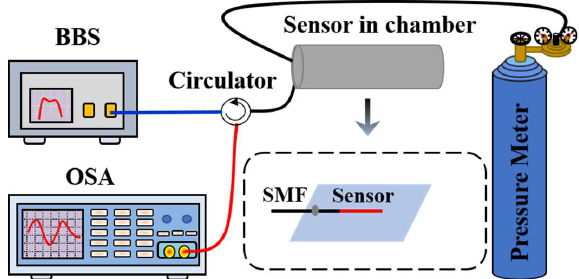
Figure 4. Experimental setup for measuring the response of the proposed sensor to the gas pressure.